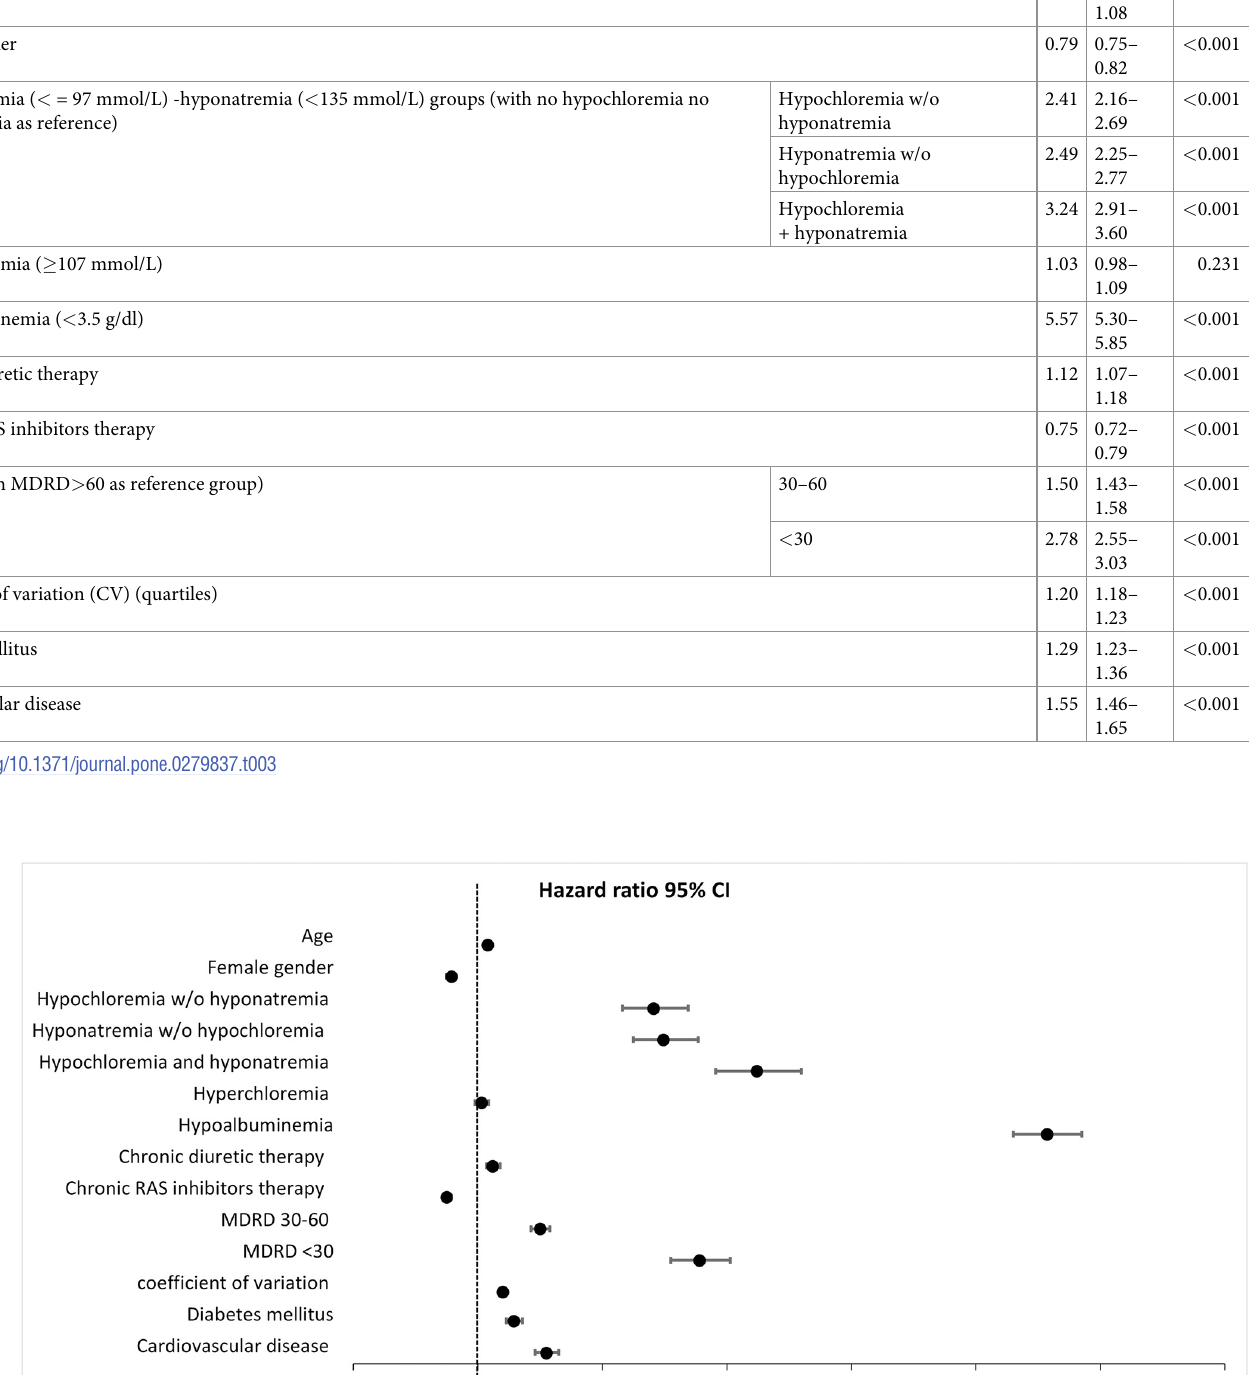
PLOS ONE | https://doi.org/10.1371/journal.pone.0279837 February 21,